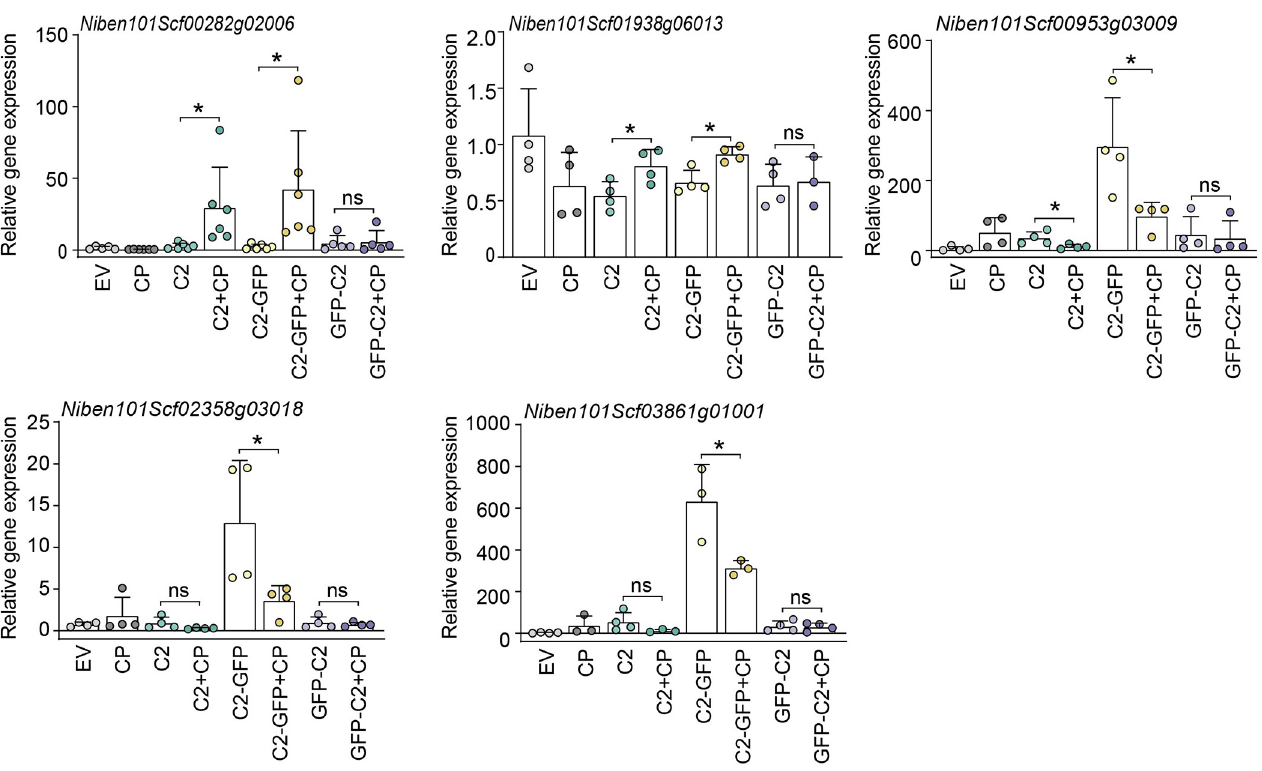
Fig 5. Expression of selected DEGs upon transient expression of C2, C2-GFP, or GFP-C2 in the presence and absence of CP in N . benthamiana leaves. Gene expression was measured by RT-qPCR. The samples expressing CP or empty vector (EV) are used as control. Expression values are the mean of at least three biological replicates. Error bars represent SD. Asterisks indicate a statistically significant difference ( � : p < 0.05, �� : p < 0.01) according to a two-tailed comparison t-test. NbACT2 was used as the normalizer.